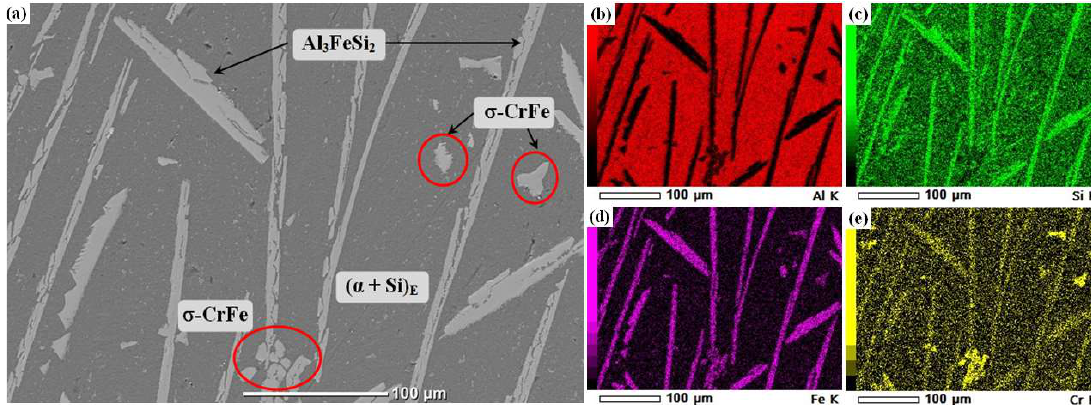
Figure 3. ( a ) Backscattered electron image (BEI) of AlSiFe with 1 wt. % Cr alloy. Elemental mapping of ( b ) aluminum, ( c ) silicon, ( d ) iron, and ( e ) chromium. Si p = Primary silicon, ( α +Si) E = Eutectic.